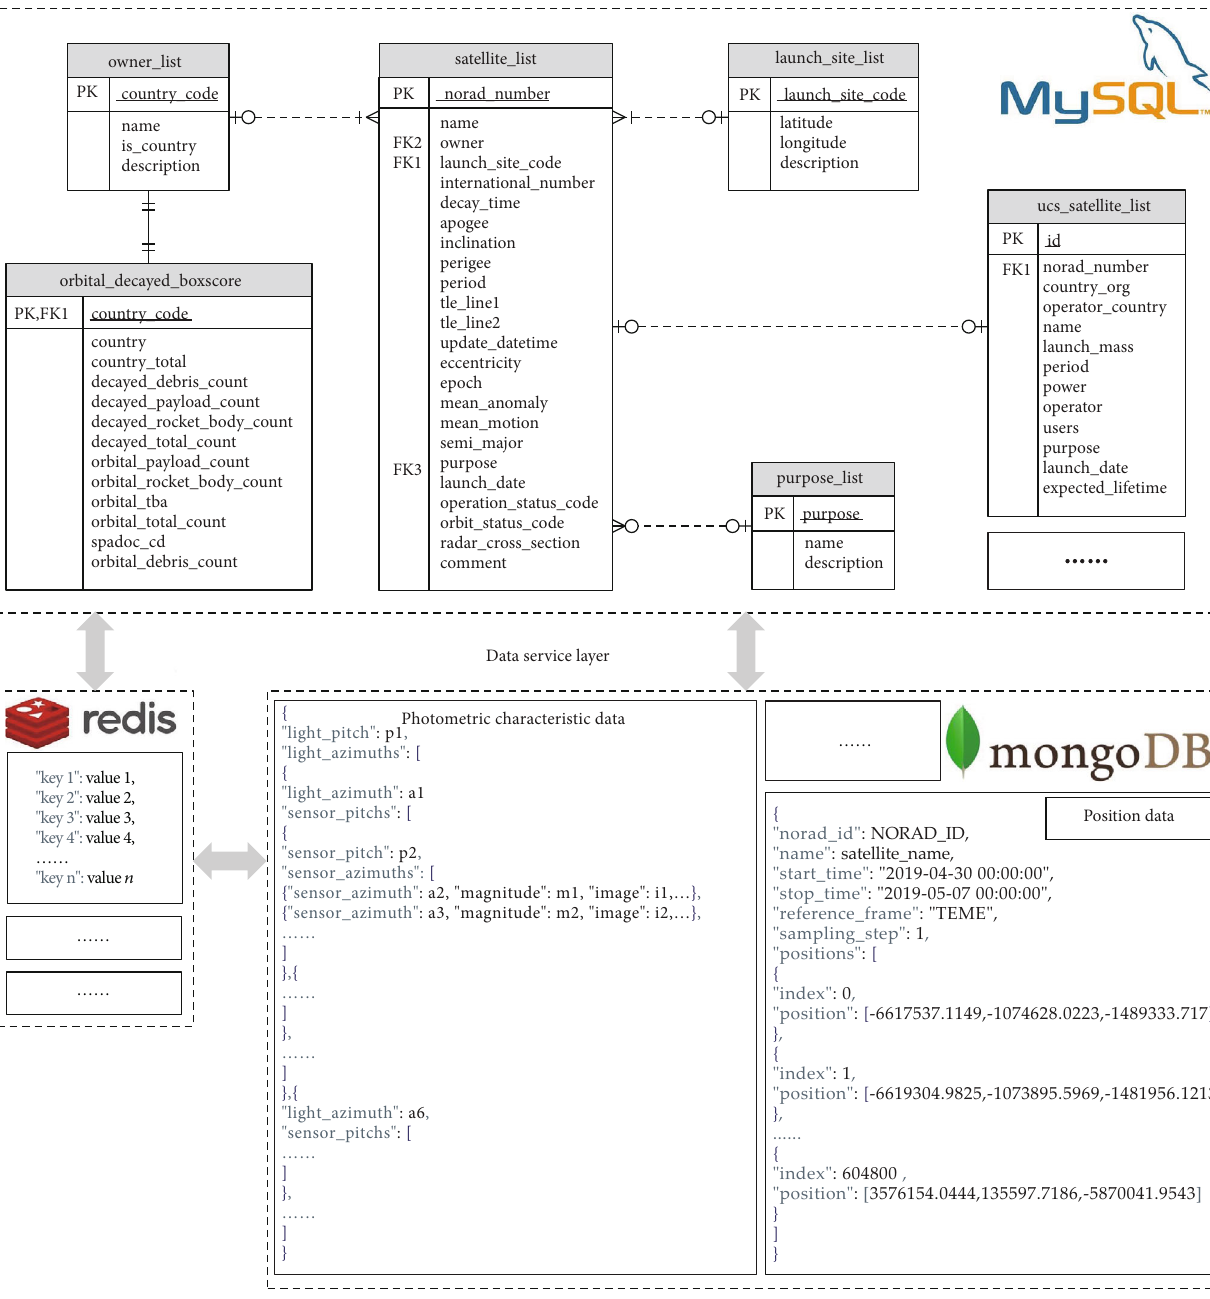
Figure 5: Data model. In MySQL, each data table is associated with the others via a certain keyword. redis, which provides the cache service, stores the processing results and the data retrieved from MySQL and mongoDB that needs to be used multiple times